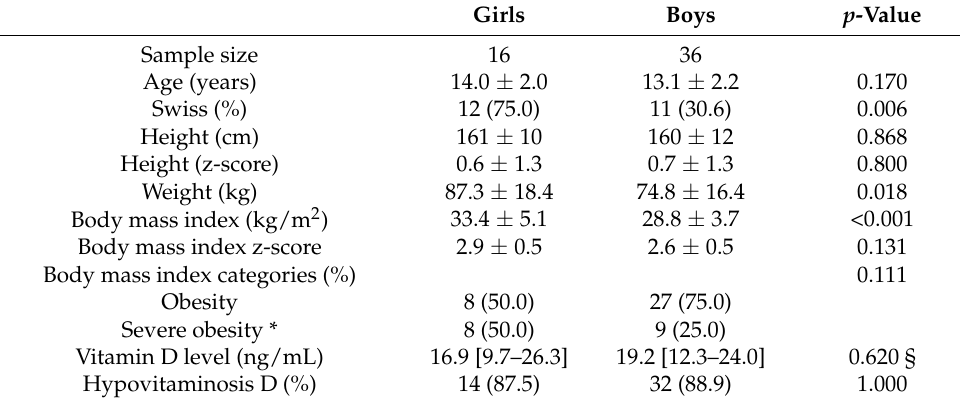
Table 1. Characteristics of the participants according to gender.